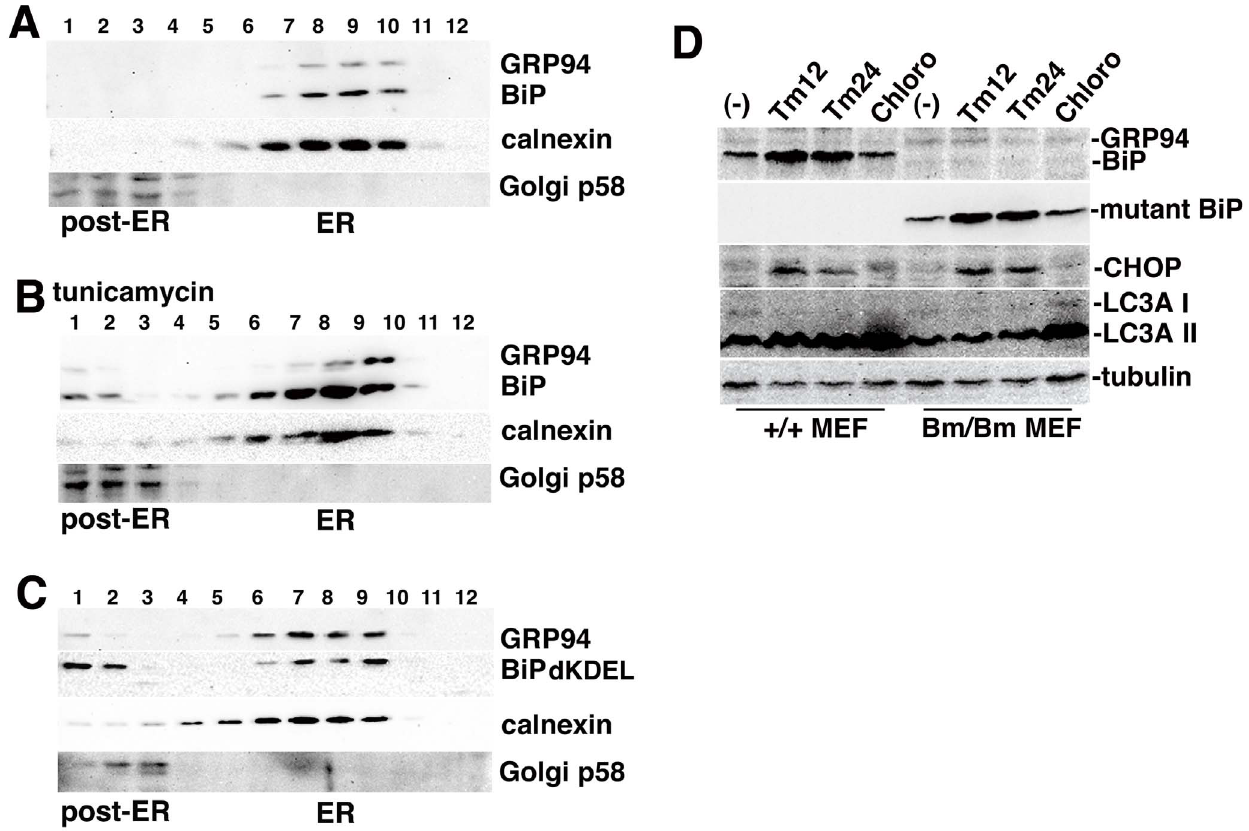
Figure 6. Lack of the KDEL sequence from BiP may lead to some functional defects of the ER chaperone in quality control and autophagy. (A, B) A fraction of BiP is secreted from the ER under stressed conditions. The postnuclear supernatants (PNS) from HeLa cells with (B) or without (A) treatment by tunicamycin 2.5 ug ml 2 1 for 24 h were separated on a continuous sucrose gradient (20% to 50%, fraction 1; top, fraction 12; bottom). An aliquot of each fraction was analyzed by SDS-PAGE. The distributions of GRP94, BiP, Golgi p58 and calnexin were determined by Western blotting. (C) HeLa cells transiently expressing the mutant BiP with the KDEL sequence deleted were collected and homogenized. The PNS from those cells were separated on a continuous sucrose gradient (20% to 50%, fraction 1; top, fraction 12; bottom). An aliquot of each fraction was analyzed by SDS-PAGE. The distributions of the GRP94, myc-tagged mutant BiP, Golgi p58 and calnexin were determined by Western blotting. (D) Wild-type MEFs and BiP MEFs were treated with tunicamycin (2.5 ug ml 2 1 for 12, 24 h) or chloroquine (50 uM for 12 h). Cells were subjected to Western blot analysis with an anti-KDEL mouse mAb for BiP, an anti-HA mouse mAb for mutant BiP, an anti-CHOP rabbit antiserum, an anti-LC3A antiserum, and an anti- tubulin